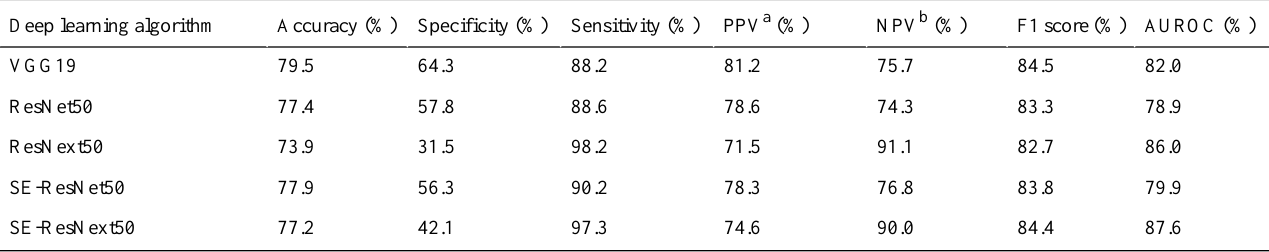
Table 2. Thyroid classification results with federated learning with internal test